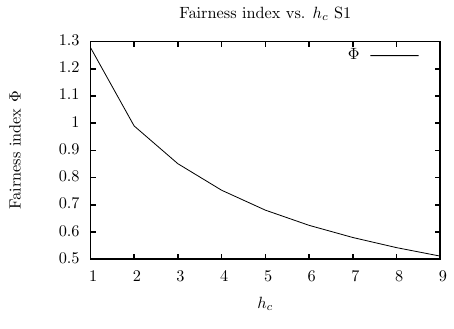
Figure 4: Throughput of classes with same rate but different